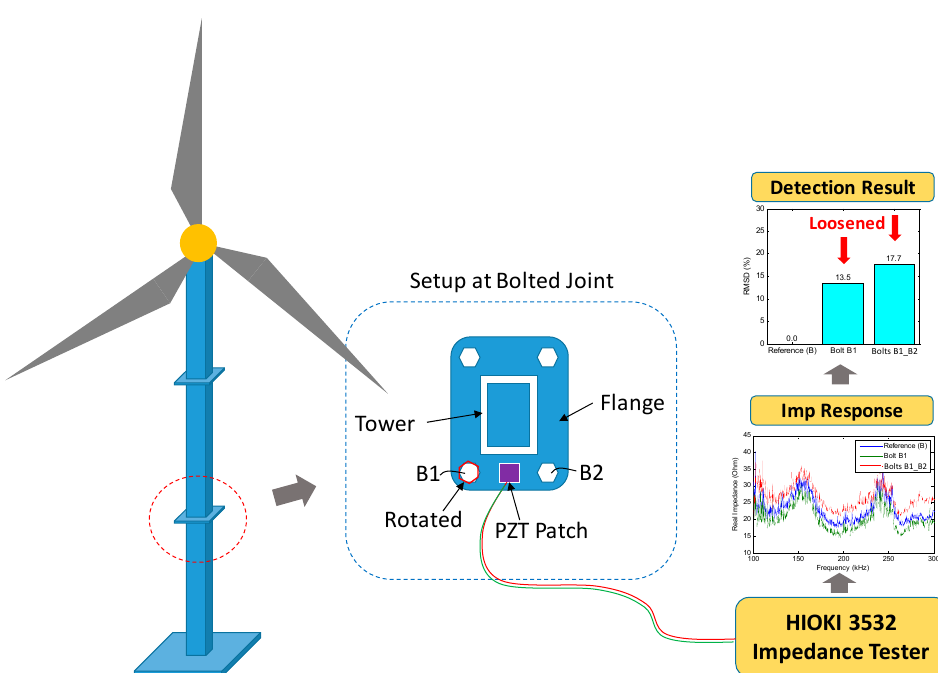
Figure 11. Impedance-based SHM of a lab-scaled wind turbine model [52].